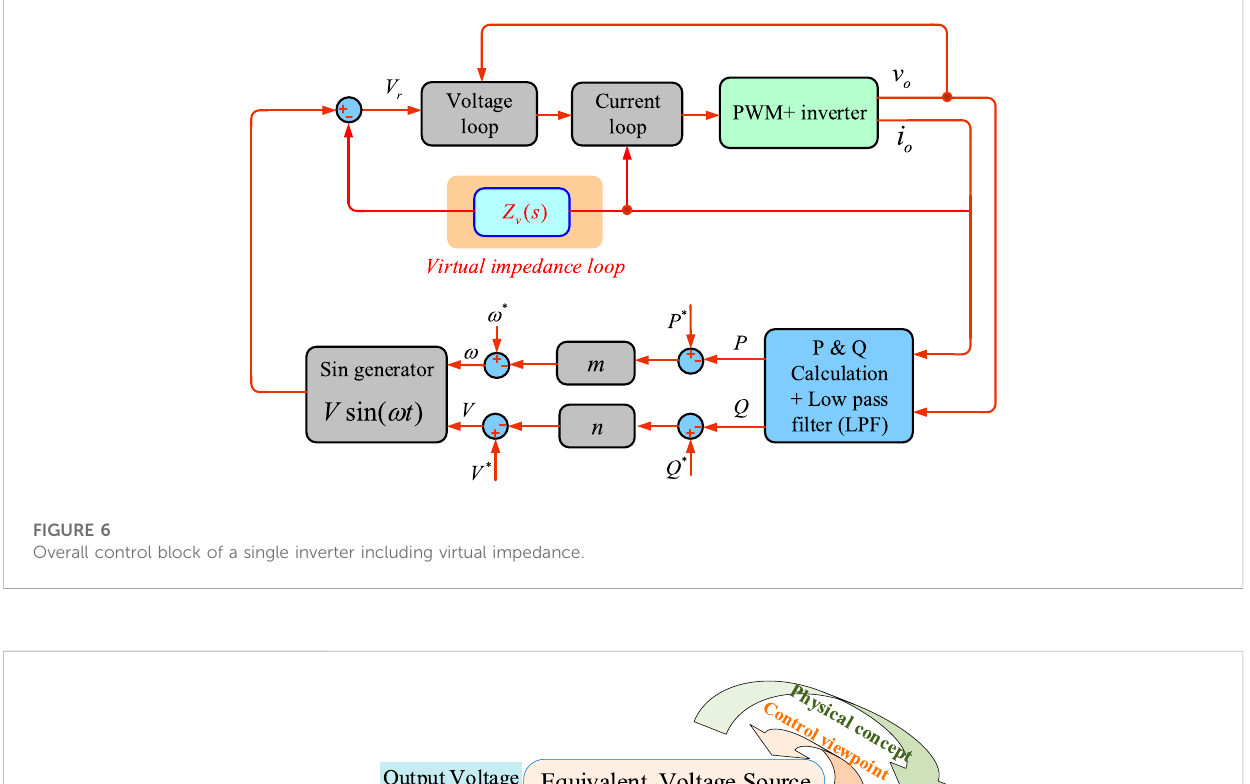
FIGURE 6 Overall control block of a single inverter including virtual impedance.